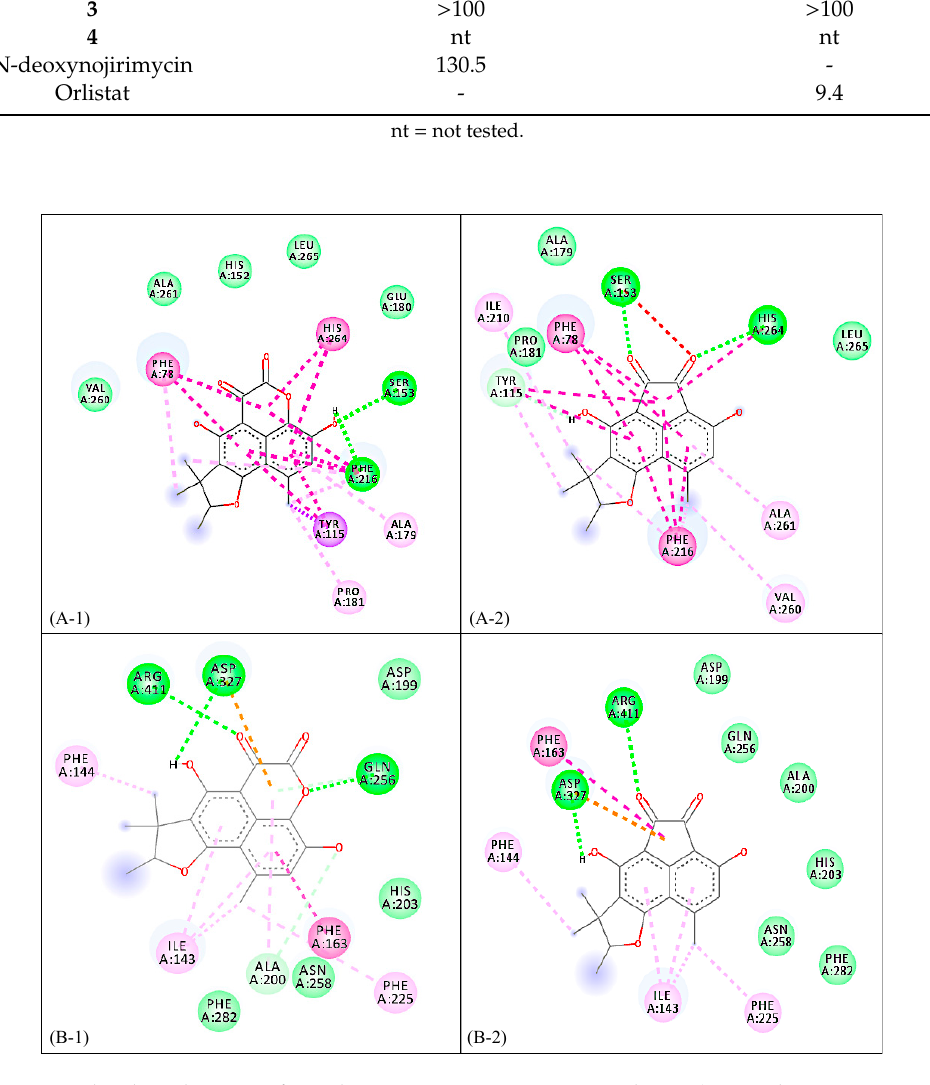
Figure 2. 2D binding diagram of 1 and 2 against porcine pancreatic lipase ( A-1 and A-2 , respectively) and α -glucosidase ( B-1 and B-2 , respectively). Table 2. Lipinski’s Rule of Five for absorption, distribution, metabolism, and excretion (ADME) analysis of isolated compounds.